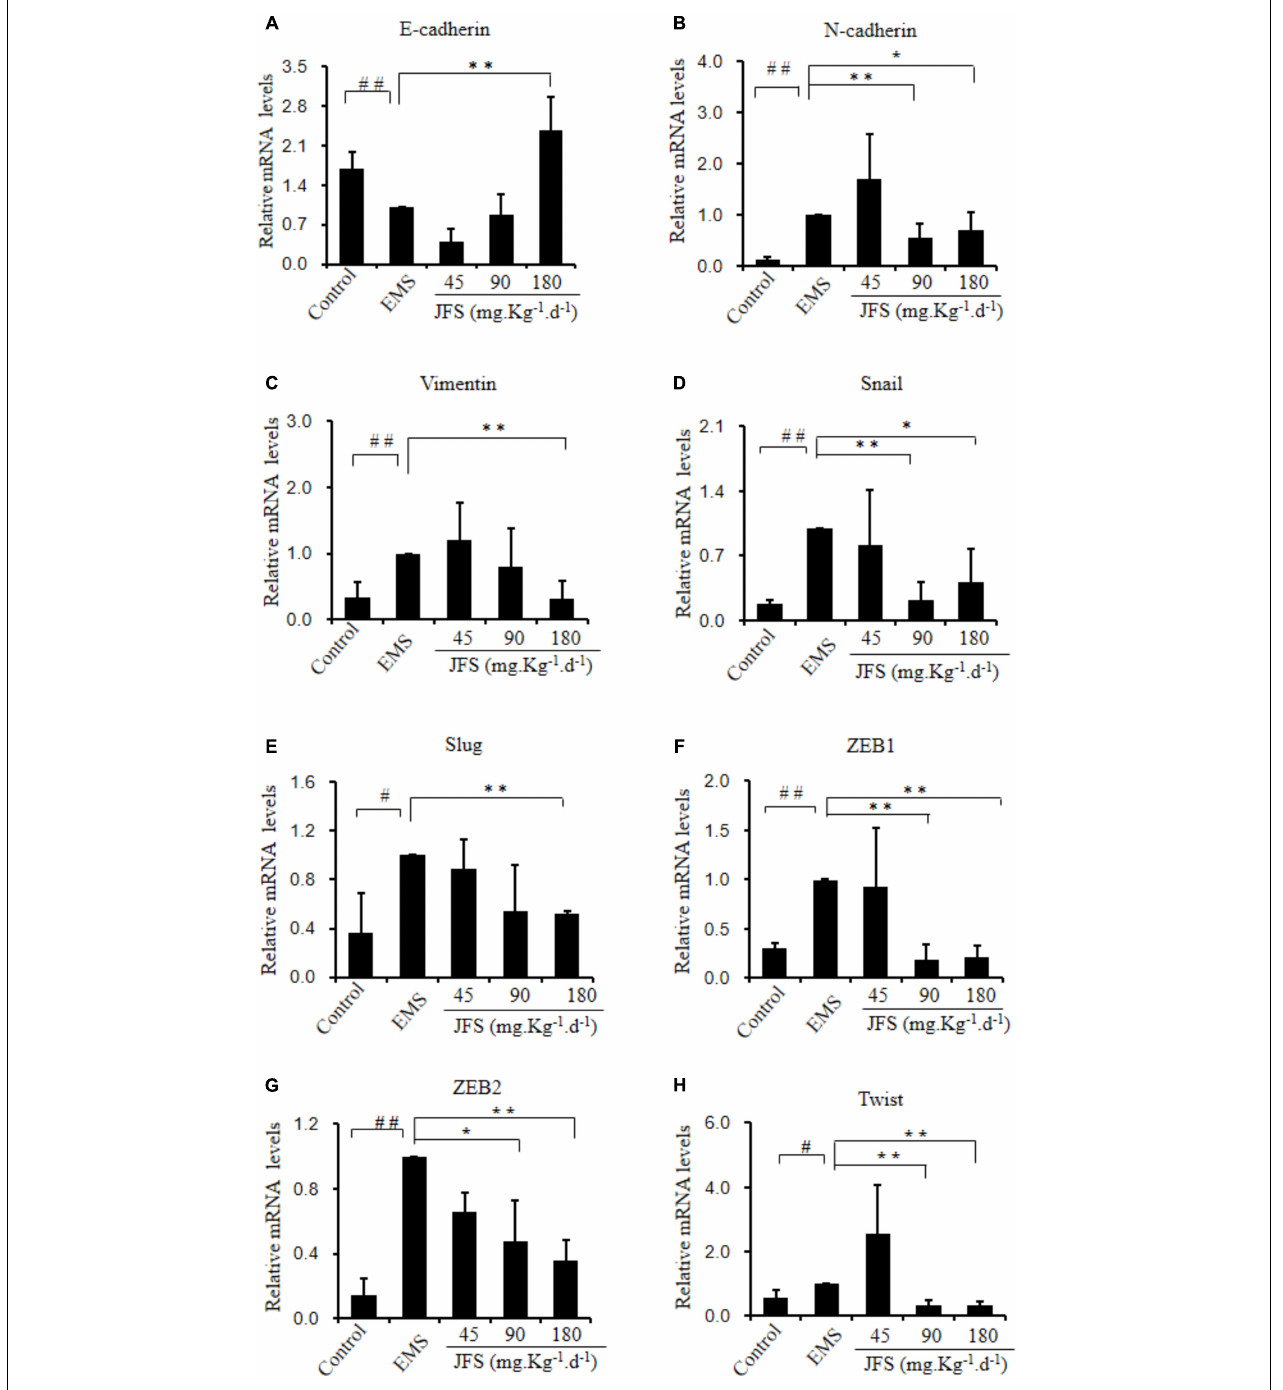
FIGURE 7 | Gene expression of epithelial–mesenchymal transition adjusted by JFS. (A) The epithelial marker E-cadherin mRNA level was measured by qPCR. (B–H) Mesenchymal genes expression of N-cadherin, Vimentin, Snail, Slug, ZEB1, ZEB2, and Twist using qPCR. # P < 0.05 to control, ## P < 0.01 to control, ∗ P < 0.05 to EMS, ∗∗ P < 0.01 to EMS. Columns, mean ( n = 3). Bars, SD. EMS, endometriosis; JFS, Jiawei Foshou San .